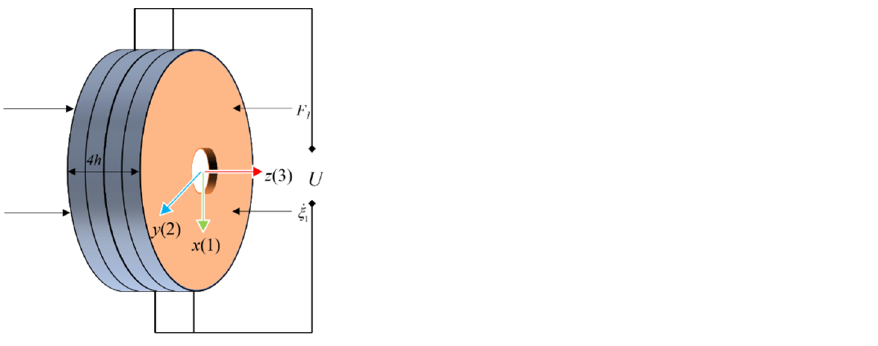
Figure 3. Electrical and mechanical boundary model of piezoelectric ceramic crystal stack.